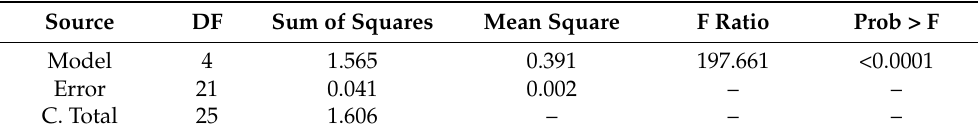
Table 10. ANOVA table of the model applied.